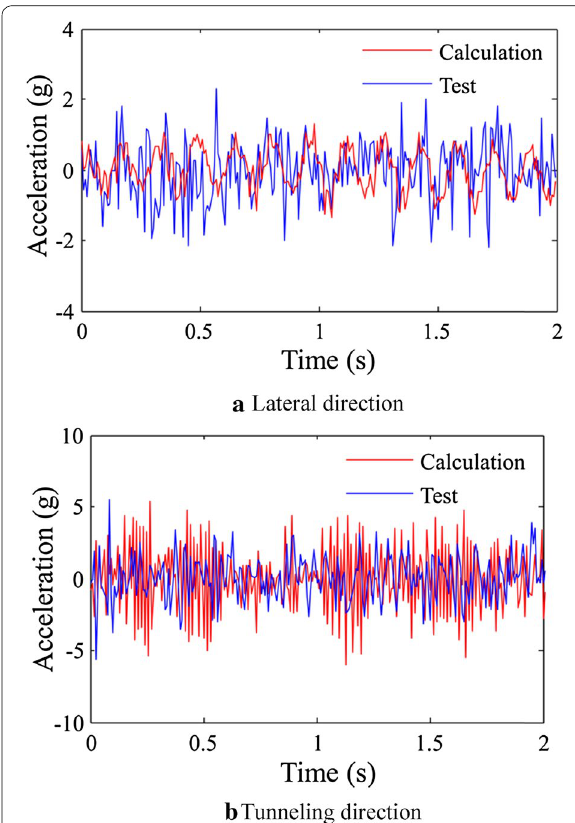
Figure 16 Measured and calculated accelerations of main